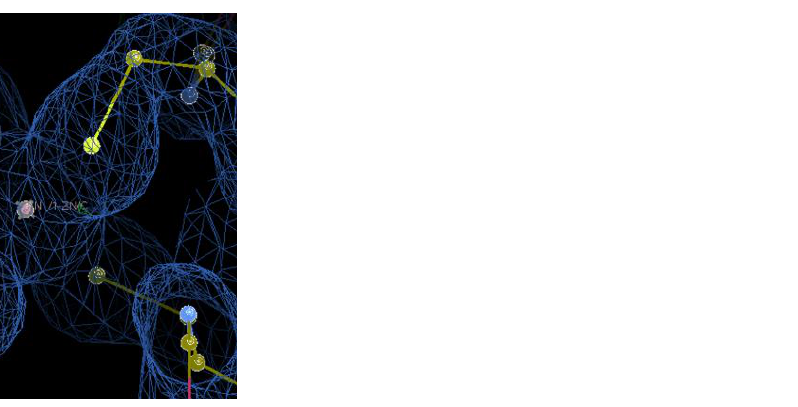
Figure 5. Metal-binding site of Zn-Atox1 crystals soaked with 2 mM EDTA for 10 min. The 2Fo-Fc electron density map (blue, 1.5σ) and Fo - Fc difference map (green +3σ and red −3σ) around the cage are shown.